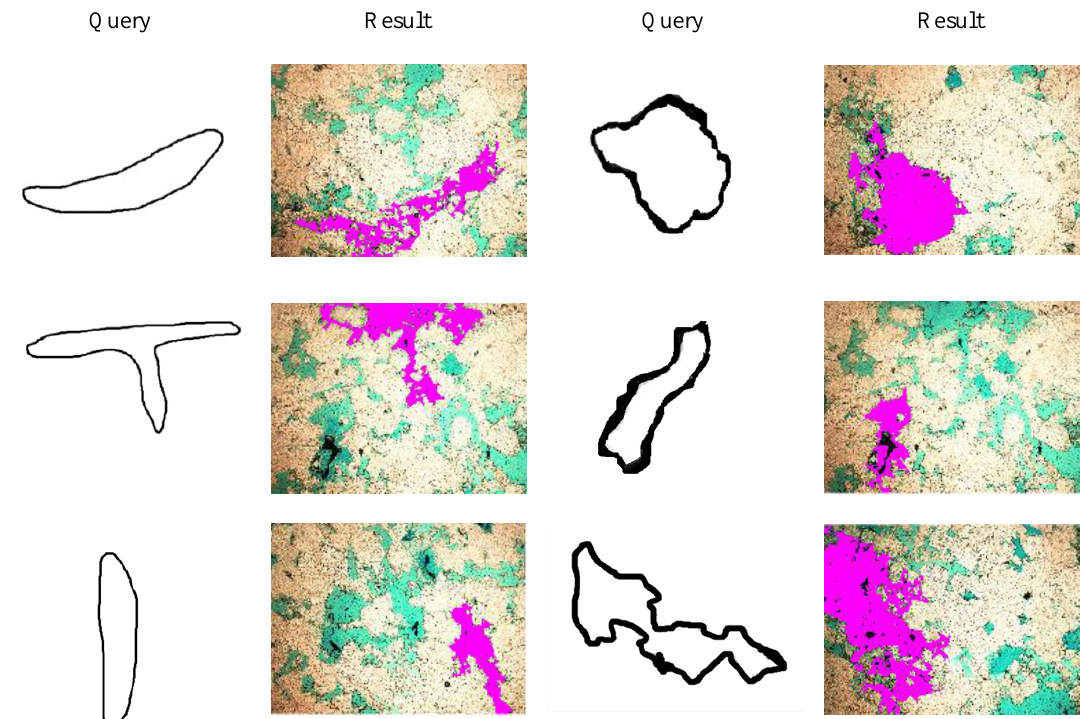
Figure 6. An example of the retrieval results of the most similar object from the analysed database of 880 images for the particular sketch query.